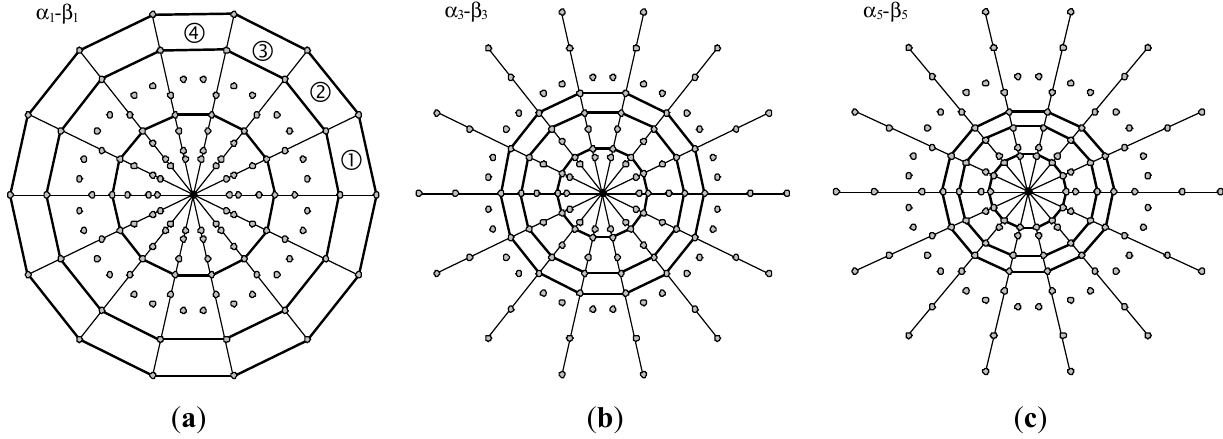
Figure 3. Space vector diagrams of inverter output voltage in the planes ( a ) α – β ; and ( c ) α ( b ) α 3 3